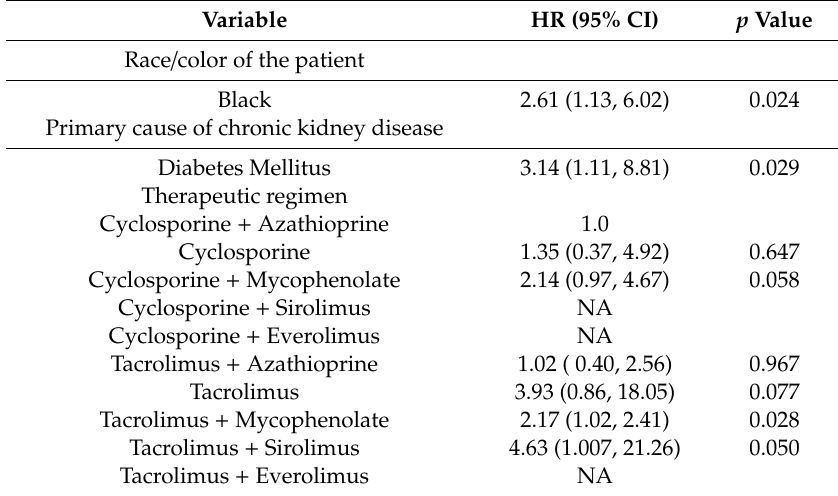
Table 5. Hazard ratios for graft loss according to Cox logistic regression of a 15-year follow-up considering patient race / color (Brazil, 2000–2015; n =